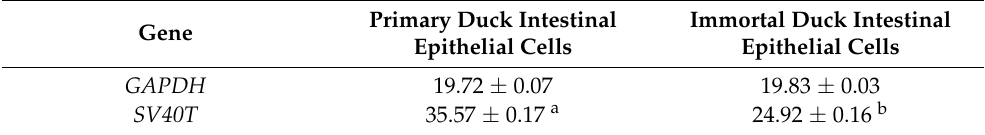
Table 2. Quantitative reverse transcription polymerase chain reaction threshold (Ct) values.